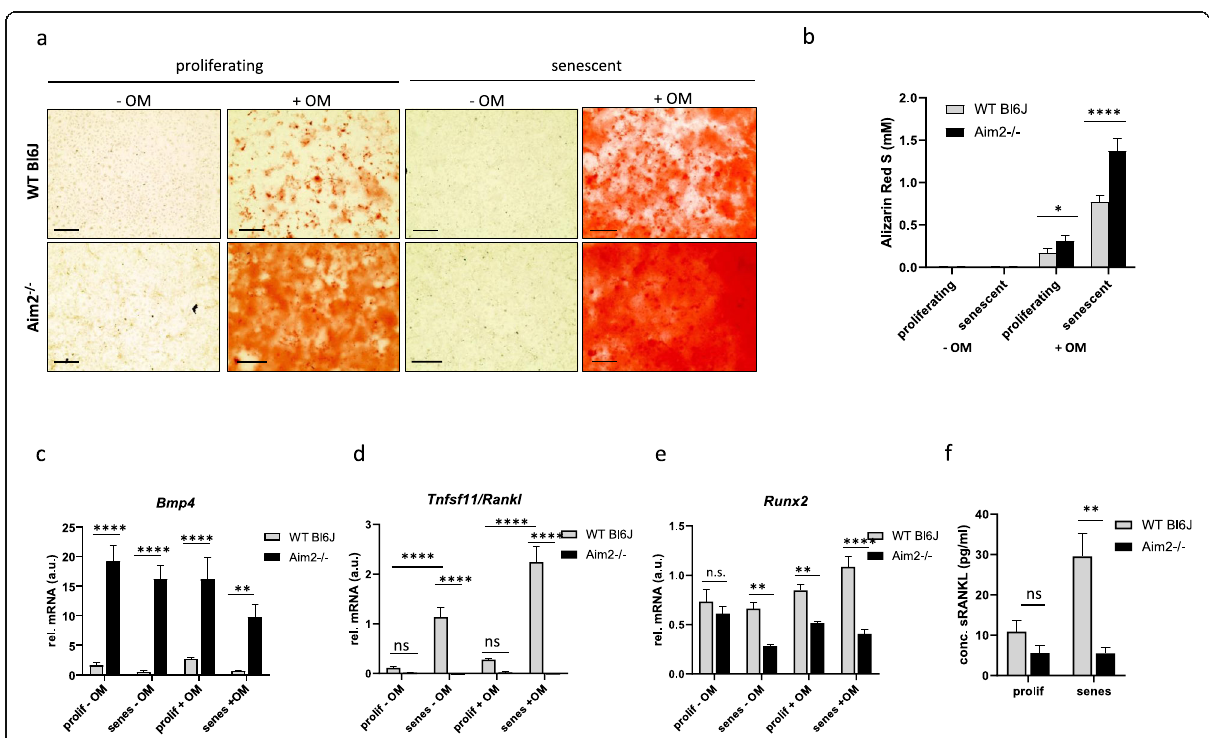
Fig. 2 Aim2 knockout increases calcification of VSMC grown in mineralization medium. a Representative images of Alizarin Red S (ARS) stained VSMC. Proliferating and senescent cells were grown in mineralization medium (+ OM) or regular SMC growth medium ( − OM). Cells were stained with ARS for visualization in triplicates at day 21. Bar: 40 μ m. b Quantitative measurement of ARS staining. ARS was eluted from the cells and analyzed photometrically at 405 nm. Bars show the mean and SD from 3 measurements of VSMC pools. c - e Analysis of mRNA expression of Bmp4 ( c ), Tnfsf11/Rankl ( d ), and Runx2 ( e ), by real-time RT-PCR. Total RNA was extracted from VSMC grown in vitro with normal growth medium ( − OM; n = 3 pools) or osteoblast mineralization medium (+ OM; n = 3 pools) at day 14. A.u. arbitrary unit; relative expression of target gene was normalized against expression of housekeeping genes ( Actb, Gapdh and B2m ). Bars represent the mean and SEM of three measurements from three pools each. a - e Data were tested by one-way ANOVA. ns: not significant, *: P < 0.05, **: P < 0.01, ****: P < 0.0001. f Concentration of murine sRANKL secreted into the supernatant, as determined by ELISA. Data show the mean and SEM of n = 3 independent experiments with different VSMC pools for each